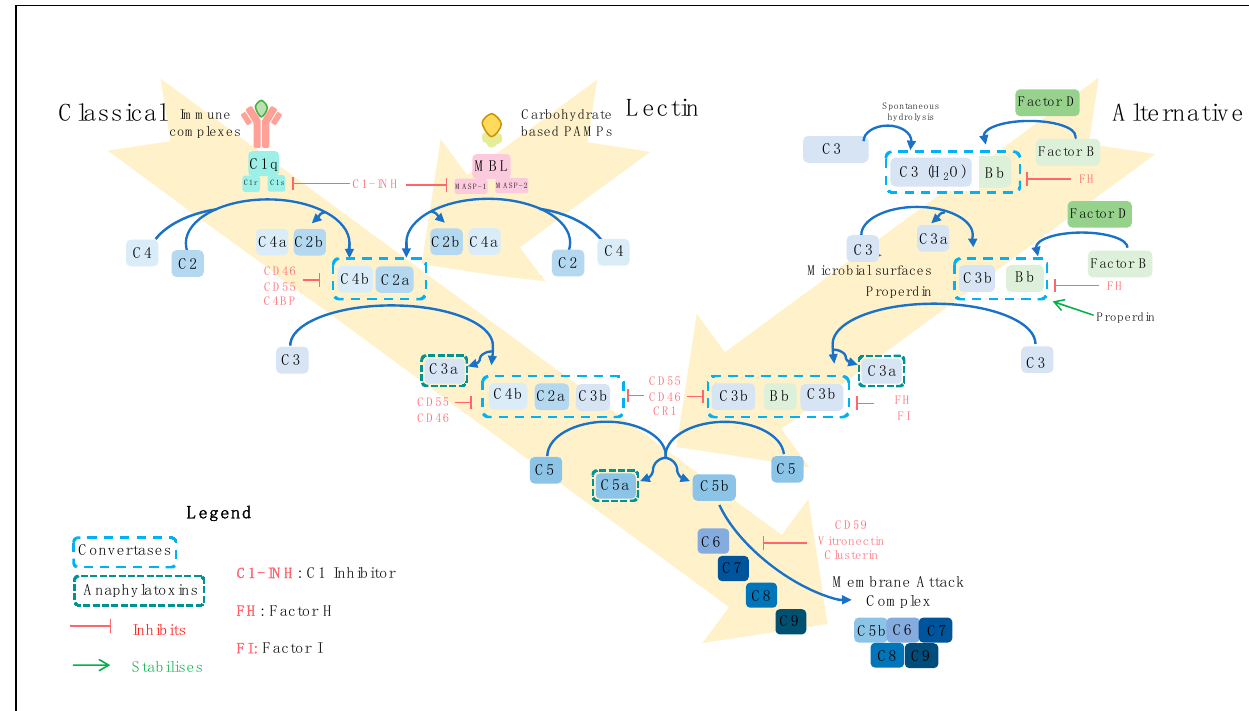
Figure 1. Complement activation pathways. There are three routes by which the complement system can become activated: the classical, the lectin and the alternative pathways. Classical pathway activation is initiated primarily by antigen-antibody immune complexes. C1q of the C1 complex (C1q, C1r and C1s) interacts with the fragment crystallistion (Fc) portion of antigen-bound immunoglobulins, activating C1r, which subsequently cleaves and activates C1s. Activated C1s cleaves C4 into C4a and C4b, and C2 into C2a and C2b leading to assembly of C4bC2a, the C3 convertase. Carbohydrate-based pathogen-associated molecular patterns (PAMPs) trigger activation of the lectin pathway. Mannose-binding lectin (MBL), ficolins or collectins recognise PAMPs, activating MBL-associated serine proteases (MASPs). Similar to the classical pathway, C4 and C2 are cleaved to generate C4bC2a. The classical and lectin complement activation pathways converge at this point to cleave C3 into the potent anaphylatoxin C3a, and C3b, which joins the C3 convertase to form C4bC2aC3b, the C5 convertase. Cleavage of C5 yields the C5a anaphylatoxin and C5b, which polymerises with C6, C7, C8 and C9 to form the membrane-attack complex (MAC). This inserts into target cell membranes to induce lysis. Spontaneous hydrolysis of C3 into C3H 2 O occurs in the alternative pathway. Cleavage of factor B (FB) by factor D yields Bb, which associates with C3H 2 O to form a C3 convertase. Cleavage of C3 and FB produces C3b and Bb, respectively. The binding of properdin to microbial surfaces recruits C3b, facilitating the assembly of the C3 convertase (C3bBb), and initiating pathway activation. Subsequent cleavage of C3 produces C3b, which combines with the C3 convertase to form a C5 convertase (C3bBbC3b). From this point, the terminal pathway is initiated to assemble the MAC, similarly to the classical and lectin pathways. Complement activation is regulated at various stages of the pathways by several membrane-bound complement regulatory proteins (Complement receptor 1 (CR1), CD46, CD55 and CD59) and circulating factors (C1-inhibitor (C1-INH), factor H (FH), factor I (FI), C4-binding protein (C4BP), clusterin and vitronectin), which are depicted in red, and properdin, which stabilises the alternative pathway C3 convertase.